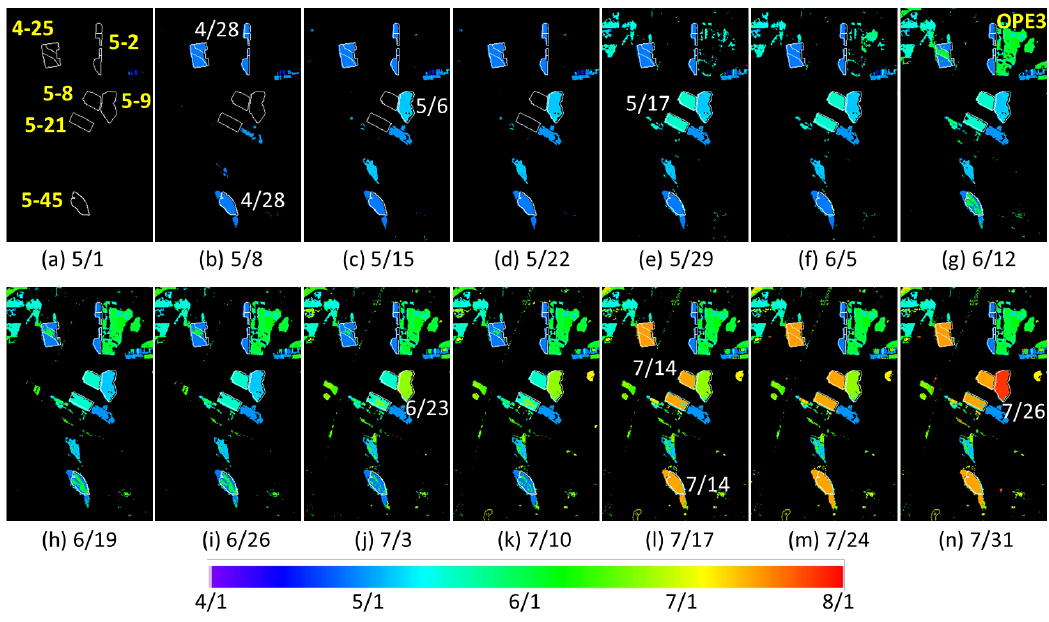
Figure 11. Cover crop termination maps from the 14 weekly near-real-time simulations (( a – n ), ending dates below subfigures) using VENµS images. Cover crop field names (yellow text) are shown in ( a ). Newly detected termination dates from six fields are shown beside the field (white text).